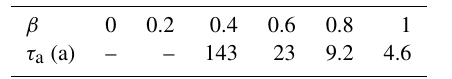
Table 2. EDML signal retrieval timescales τ a after block averaging accounting for precipitation intermittency, diffusion, and measure- ment noise.